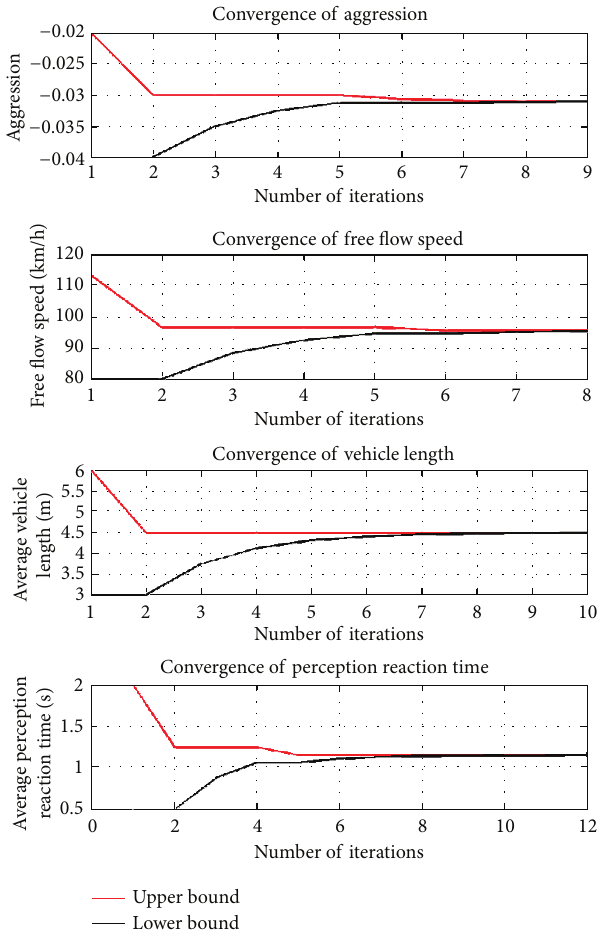
Figure 5: Steps for parameters to converge in bisection calibrating